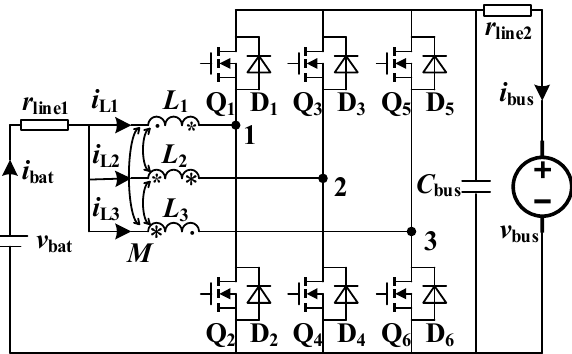
Figure 1. The topology of a 3-phase coupled buck–boost converter.